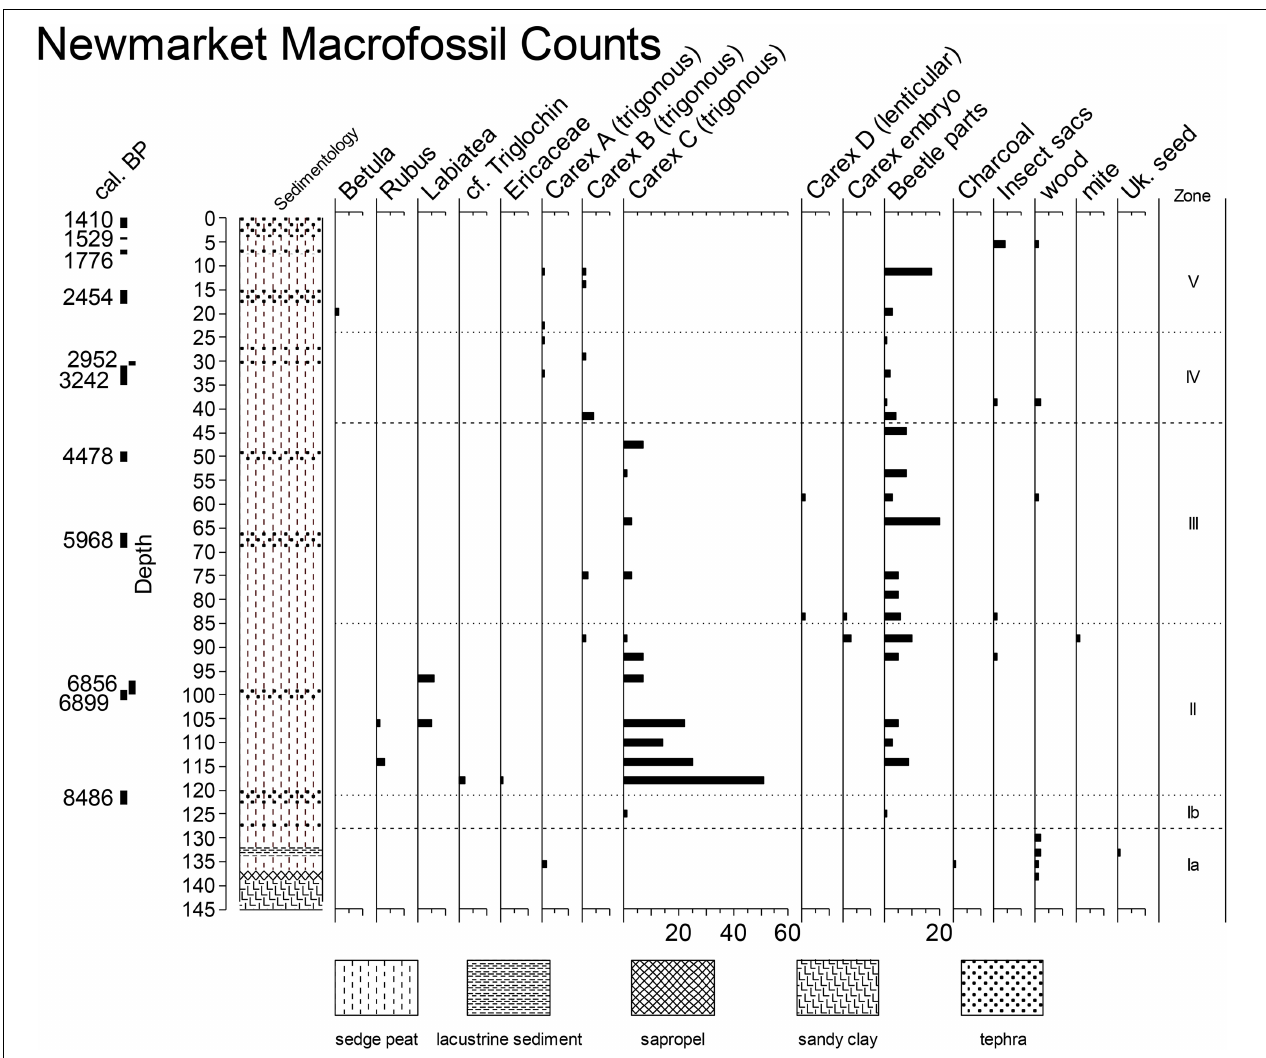
FIGURE 2 | Macrofossil counts at Newmarket Fen along with core stratigraphy. Zonation based on macrofossil analysis is indicated with heavy dashed lines and zonation based on n -alkane abundances is indicated with light dotted